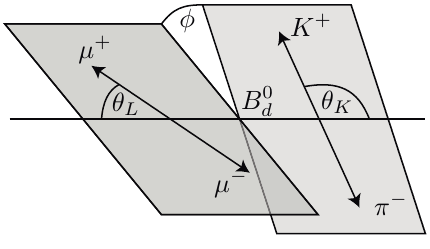
Figure 3. Definition of the kinematic angles in the decay B 0 d → K ∗ 0 μ + μ − [5].